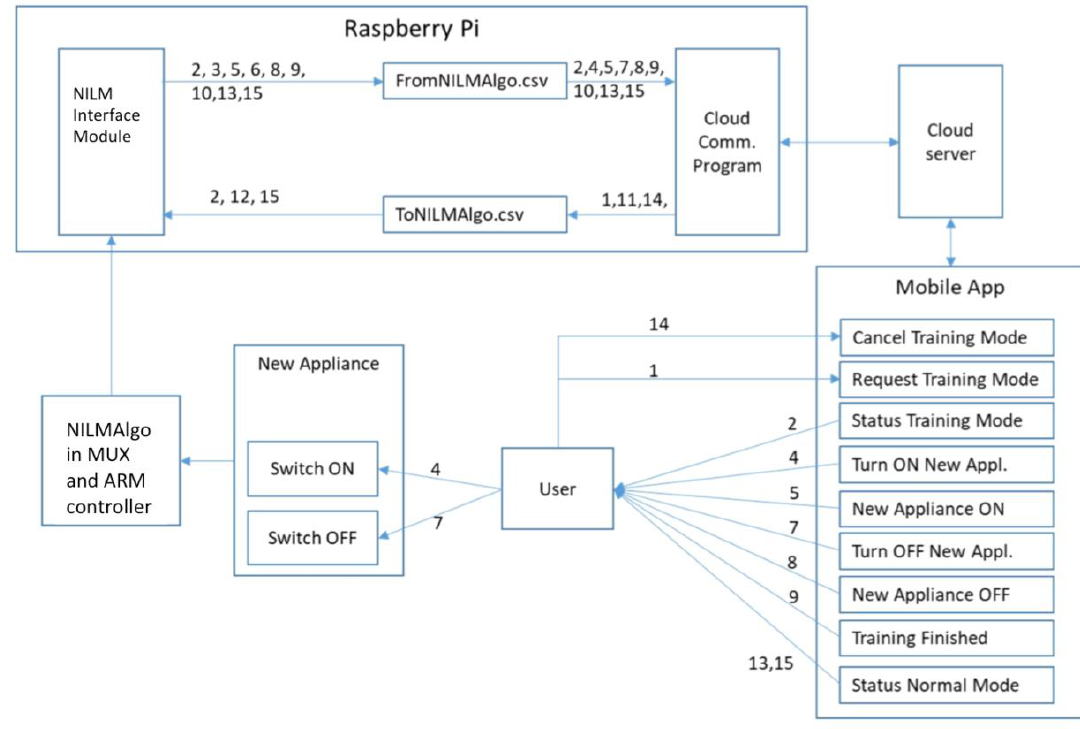
Figure 11. Data Flow of Non-Intrusive Load Monitoring (NILM) Program.